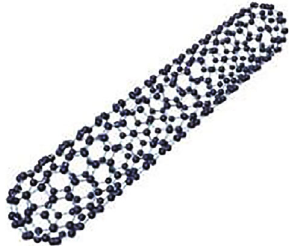
Figure 1: Carbon nanotube. Table 1: Carbon nanotube